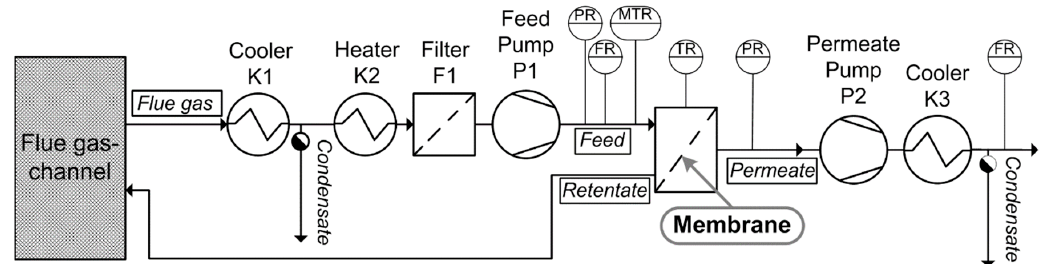
Figure 5. Simplified flow sheet of the single membrane test rig.